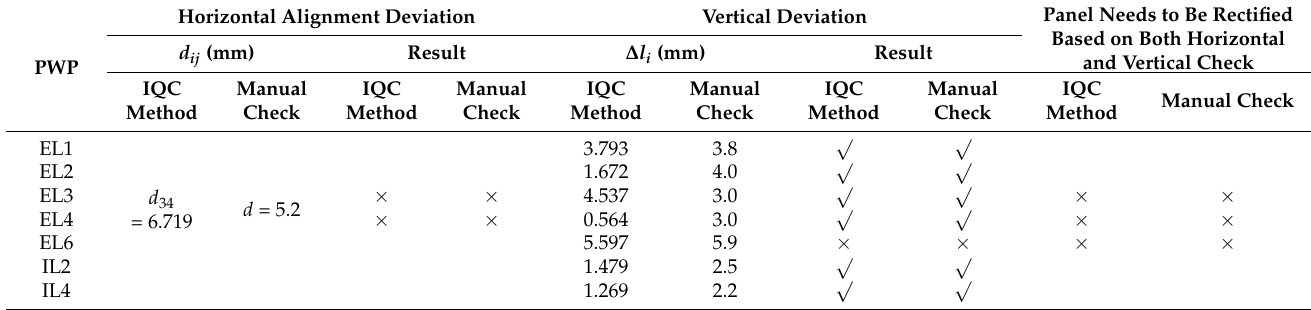
Table 8. Results of proposed IQC method using laser scanning and manual